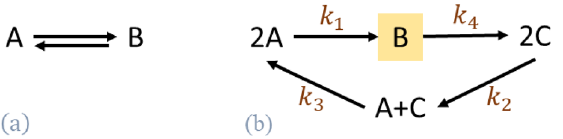
Figure 1. The distinction of three notions related to balanced complexes. (1) The diagram ( a ) depicts a complex balanced network. (2) The network in diagram ( b ) is not complex balanced. However, assuming mass action kinetics and under the particular condition k 1 k 2 = k 32 , all complexes are balanced at steady state. (3) The complex B [highlighted in ( b )] is a balanced complex at all steady states regardless of the kinetic law governing the